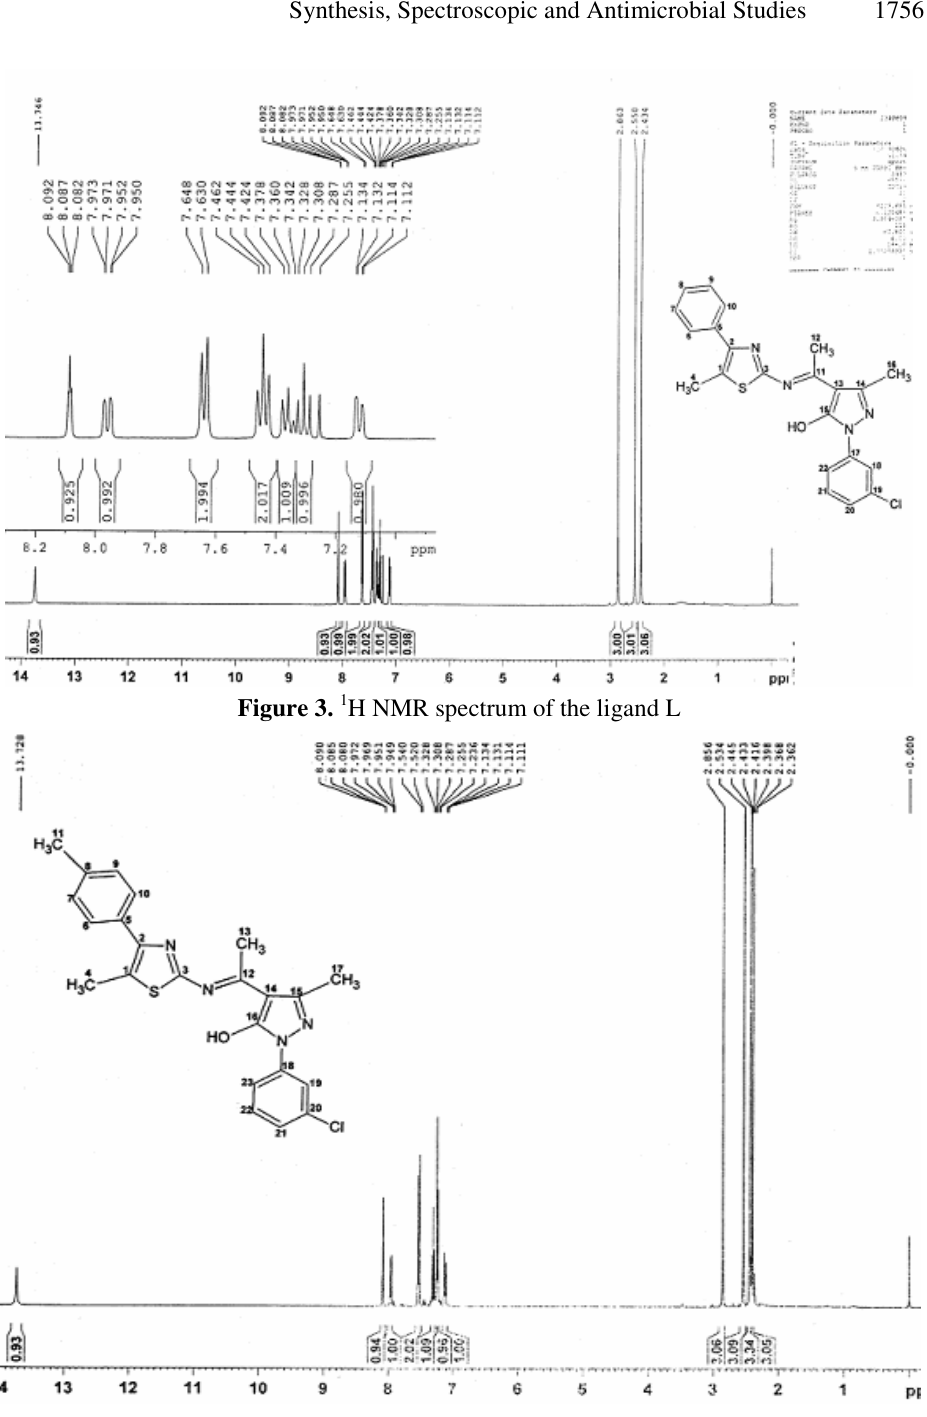
Figure 4. 1 H NMR spectrum of the ligand L